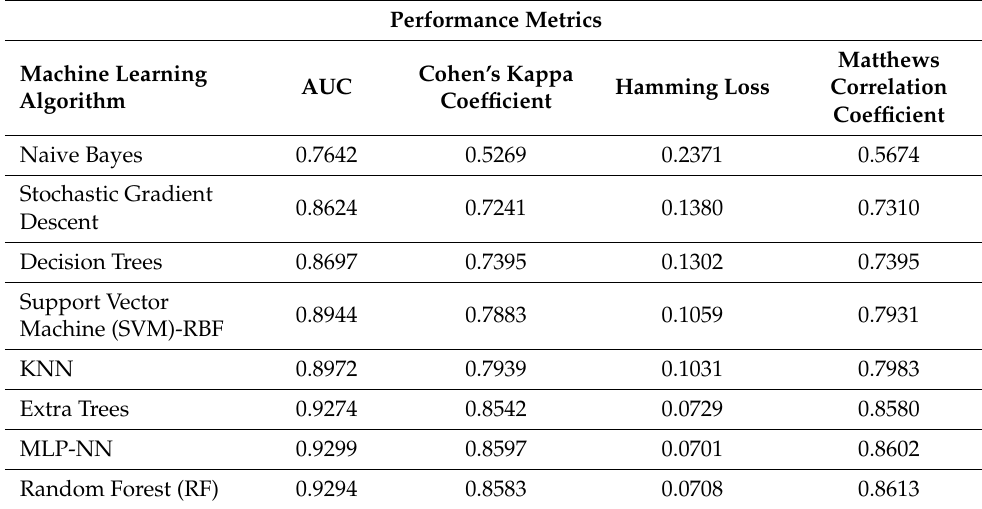
Table 3. Performance metrics of the eight ML algorithms evaluated in this